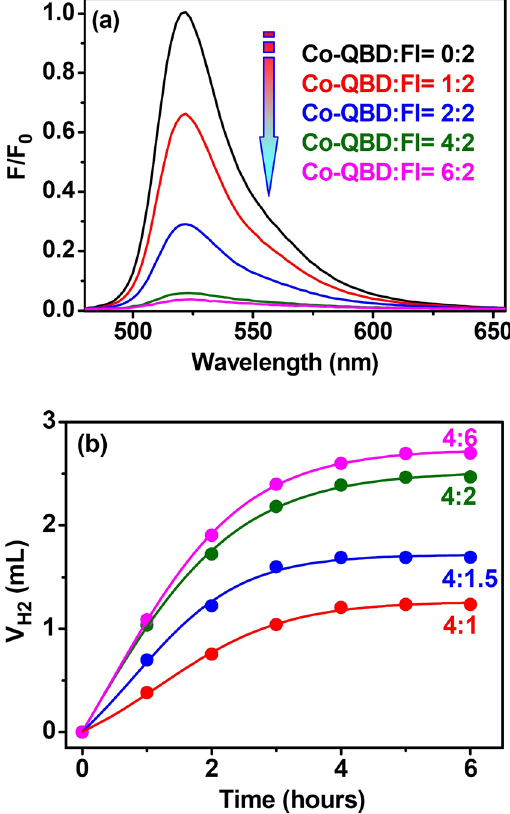
Figure 6. ( a ) Family of the emission spectra of Fl (0.01 mM) in the presence of TEA in 1:1 CH 3 CN/H 2 O at pH 11.0 after the addition of different concentrations of Co– QDB . ( b ) H 2 production after irradiation the system containing TEA (5%), Co– QDB (80 μ M) and different concentrations of Fl